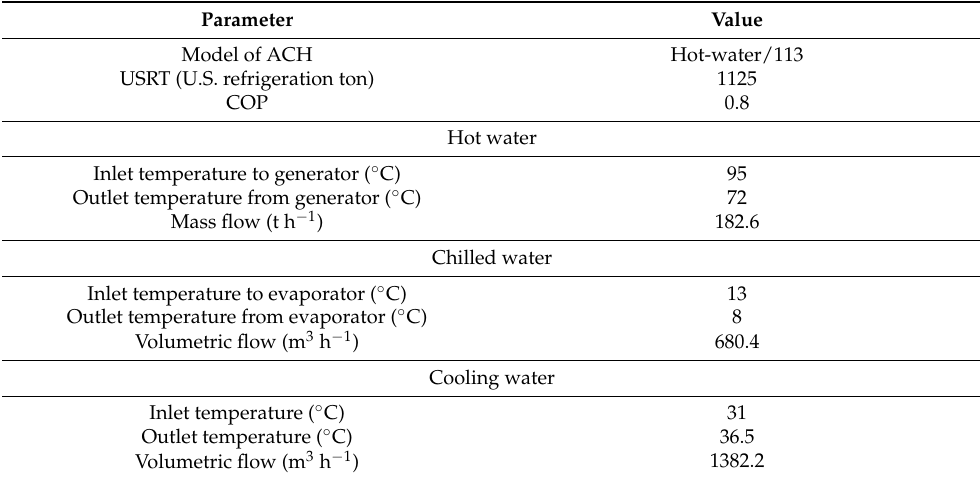
Table A5. Parameters of ACH placed after second compression stage. Source: